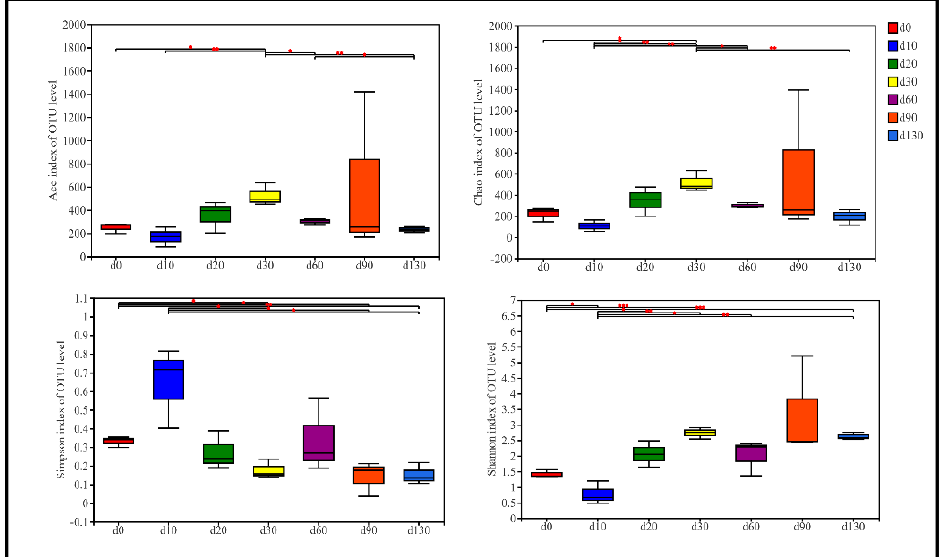
Figure 2. The dynamics of bacterial community aphla diversity indices including chao, ace, Simpson and Shannon during sufu fermentation, significant value are shown as: * p < 0.05, ** p < 0.01, *** p < 0.001.